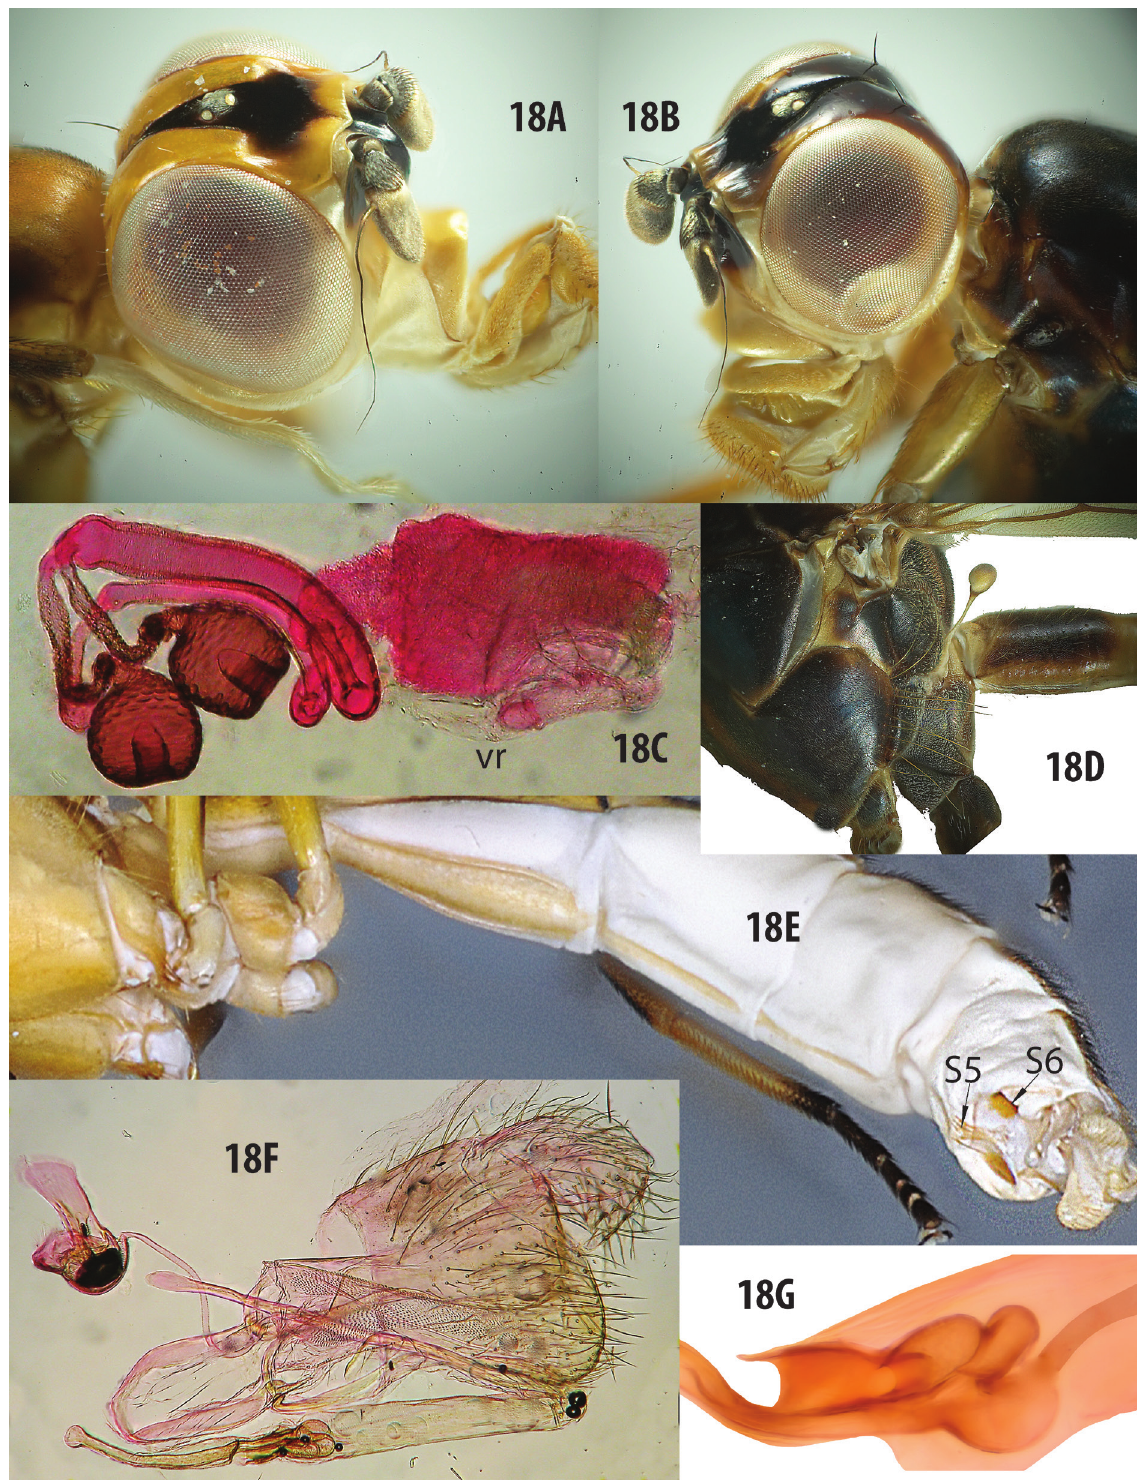
Fig. 18. Mesoconius suzukii sp. nov . A . Typical head. B . Dark head. C . Spermathecae and associated structures. D . Mesopleuron and base of abdomen. E . Abdomen, ♂, ventral view. F . Male terminalia, left lateral view. G . Phallic bulb. Abbreviation: vr = ventral